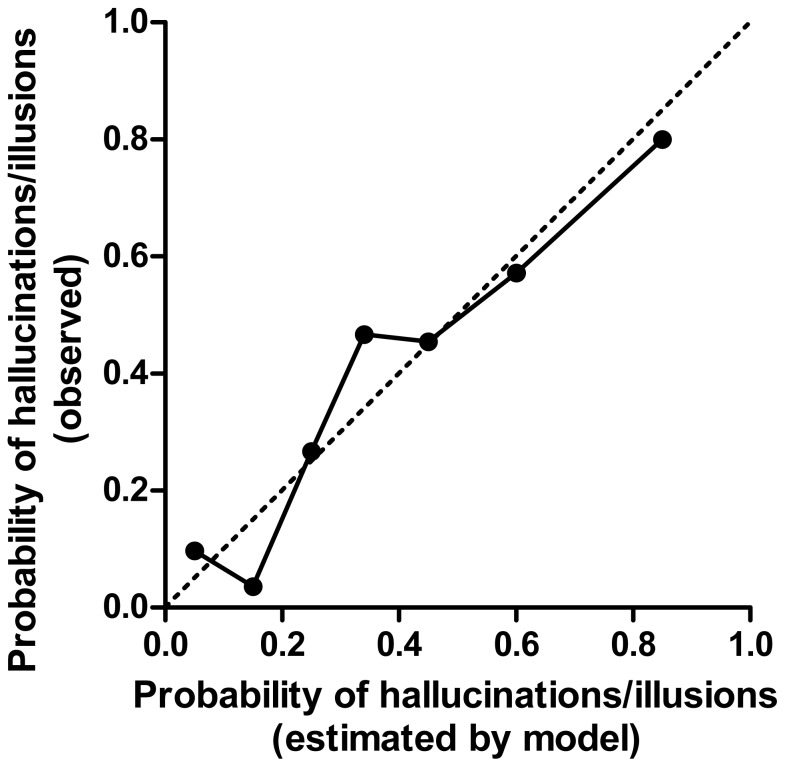
Observed and estimated probability of hallucinations/illusions.Line demonstrates the relationship between the observed probability of hallucinations/illusions and that estimated in the logistic regression model incorporating plasma CRP, age and MMSE as predictable variables.